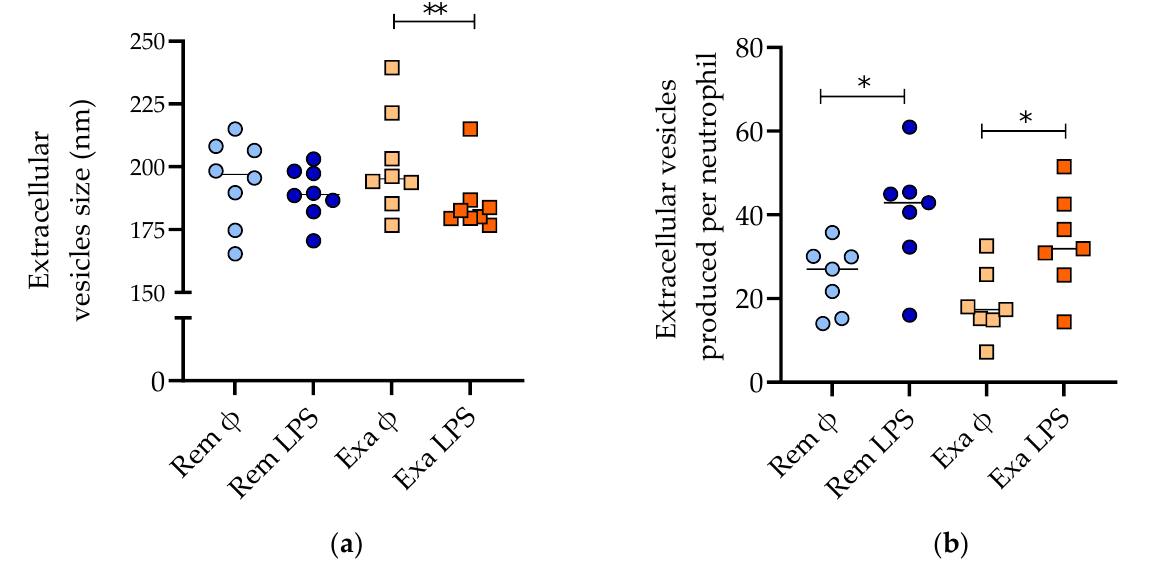
Figure 3. Neutrophil extracellular vesicle characterization by laser scattering microscopy. Size ( a ) and production per neutrophil ( b ) during remission (Rem) and exacerbation (Exa) (dot plot with mean). φ : untreated cells; LPS: cells treated with 100 ng/mL LPS. * p < 0.05, ** p < 0.01 with Bonferroni multiple comparison tests.